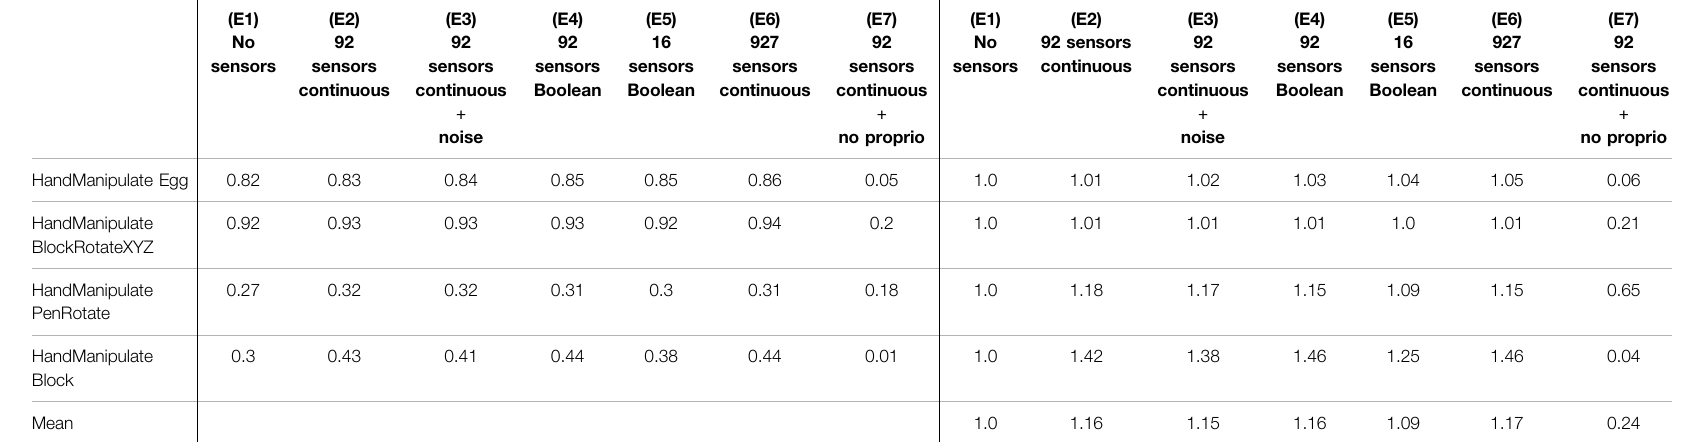
TABLE 4 | Experiments E1 – E7 ( Figure 4 ): Success Rate Convergence Levels (columns 2 – 8) and Performance Ratio (columns 9 – 15).